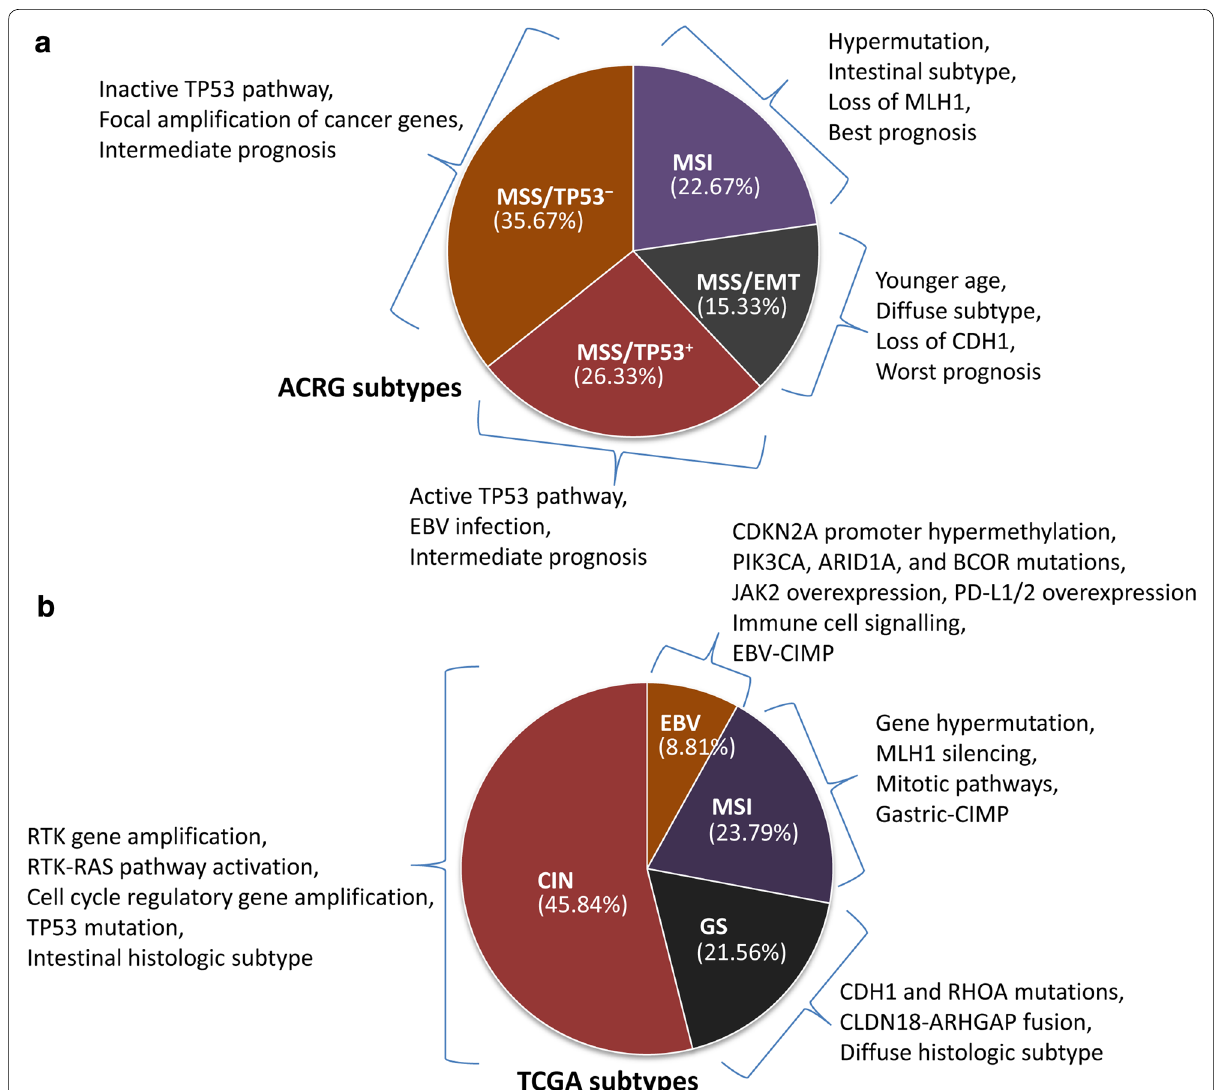
Fig. 1 Molecular classifications of gastric cancers (GCs): a the Asian Cancer Research Group (ACRG) classification; b the Cancer Genome Atlas (TCGA) classification. MSS microsatellite stable, TP53 tumor protein 53, MSI microsatellite instable, EMT epithelial‑mesenchymal transition, MLH1 mutL homolog 1, CDH1 cadherin 1, EBV Epstein‑Barr virus, CIN, chromosomal instability, GS genomically stable, RTK receptor tyrosine kinase, RAS resistance to audiogenic seizures, CDKN2A cyclin‑dependent kinase inhibitor 2A, PIK3CA phosphatidylinositol‑4,5‑bisphosphate 3‑kinase catalytic subunit alpha, ARID1A AT‑rich interactive domain 1A, BCOR BCL6 corepressor, JAK2 janus kinase 2, PD-L programmed cell death ligand, CIMP CpG island methylator phenotype, RHOA ras homolog family member A, CLDN18 claudin 18, ARHGAP Rho GTPase‑activating protein